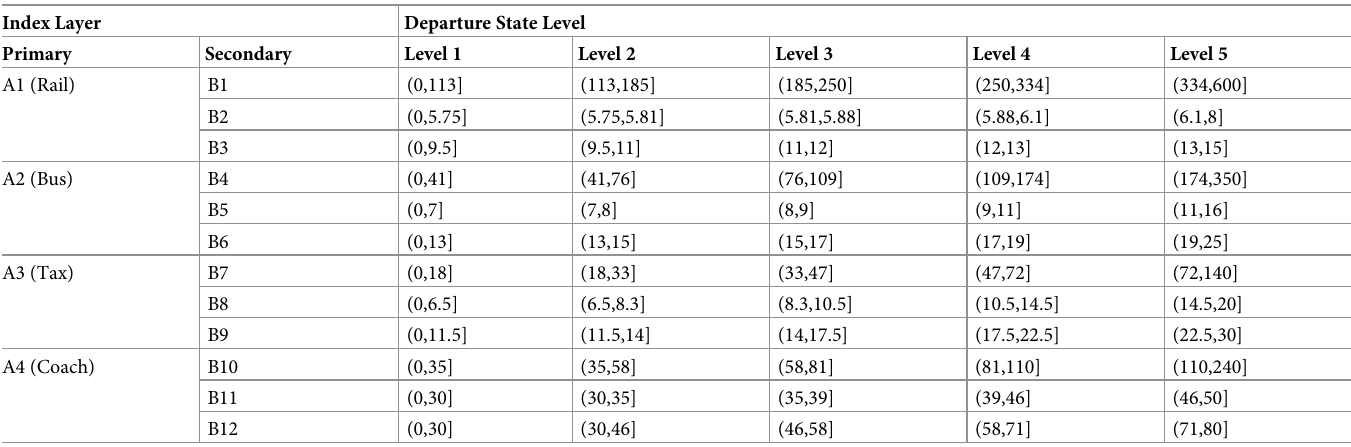
Table 8. Range of passenger departure states.